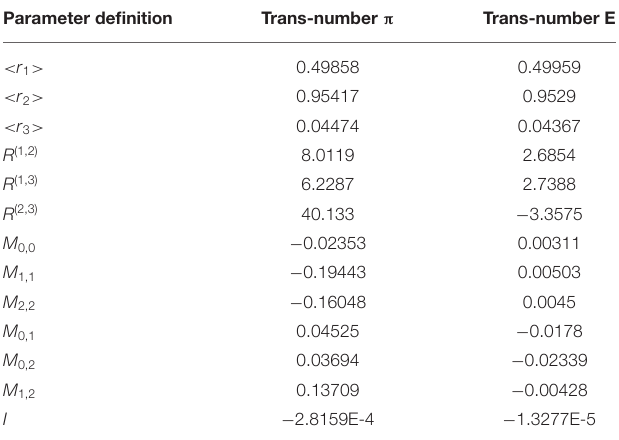
TABLE 1 | The comparison of the 13 basic parameters that correspond to the trans-numbers π and E .